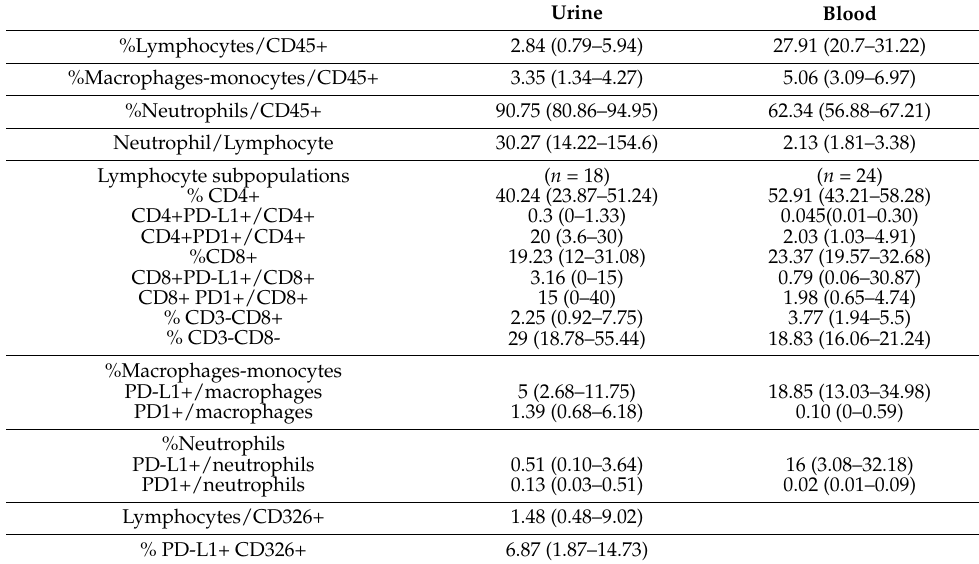
Table 2. Cell composition of urine and blood from MIBC patients.